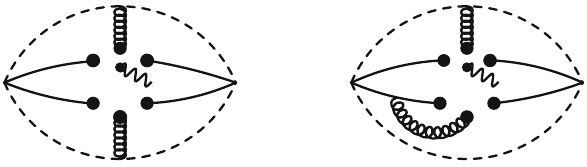
Fig. 2 The contributions (cid:3)¯ qq (cid:4)(cid:3)¯ qg s σ Gq (cid:4) F αβ come from the terms (cid:3) 0 | q i ( x ) ¯ q j ( 0 ) G n ( x ) | 0 (cid:4) F , where the external lines denote the pho- αβ ton field. Other diagrams obtained by interchanging of the heavy quark lines (dashed lines) or light quark lines (solid lines) are